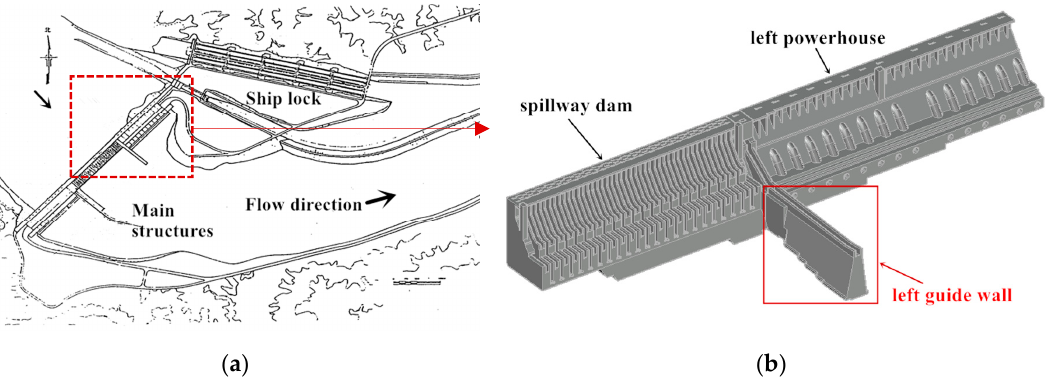
Figure 1. Hydraulic structures of the Three Gorges Hydropower Station (TGHS). ( a ) The layout of the TGHS project; ( b ) the enlarged view of left guide wall, spillway guide wall, and left powerhouse.